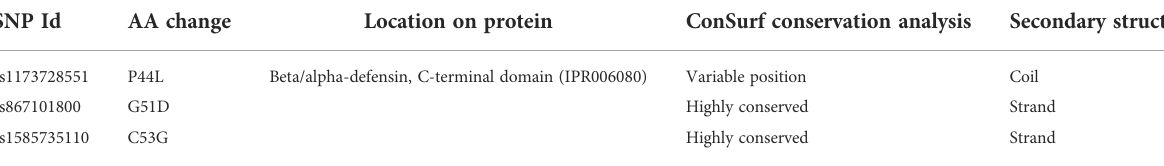
TABLE 3 Locations of the selected residues on h BD-2 domains, ConSurf conservation analysis, and predicted secondary